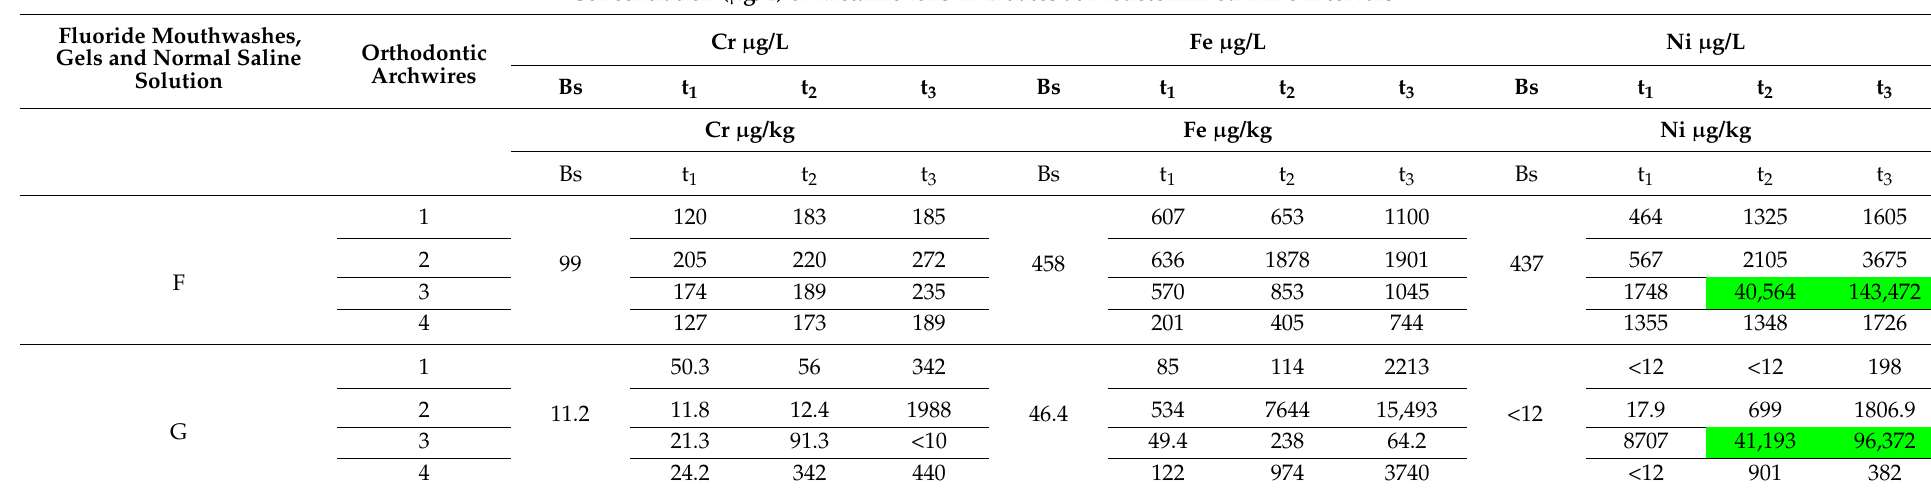
Concentration ( µ g/L) of Metallic Ions in Eluates at Predetermined Time Intervals